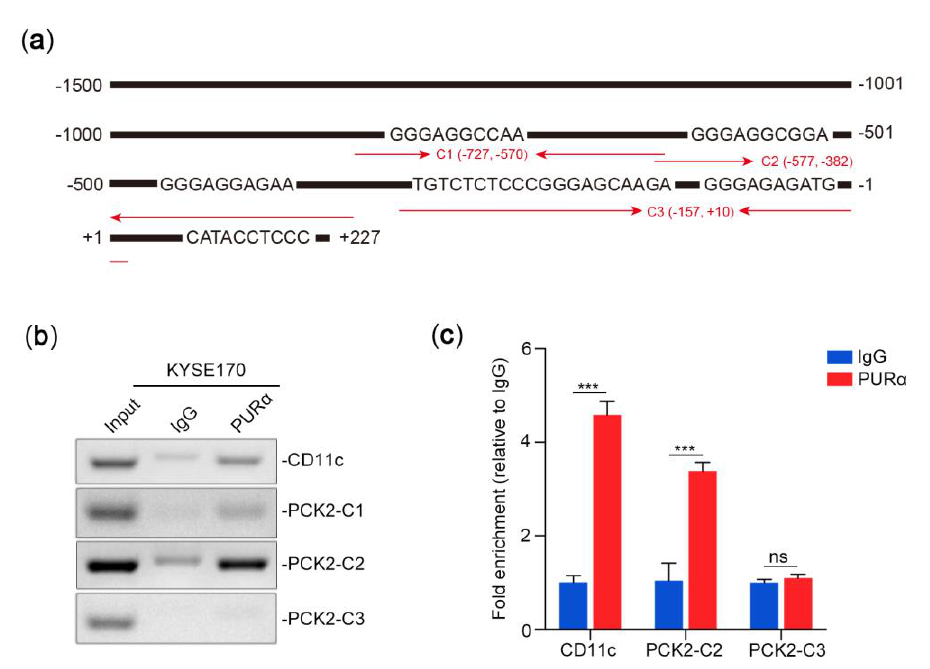
Figure 8. PUR α binds directly to the promoter region of PCK2. ( a ) Schematic diagram showing the specific motifs of 7 PUR α predicted binding sites and the designed C region verified by ChIP-PCR (C1: − 727 / − 570; C2: − 577 / − 382; C3: − 157 /+ 10). ( b ) ChIP-PCR analysis of PUR α binding to the PCK2 promoter region (C1, C2 and C3) and CD11c as a positive control in KYSE170 cells. ( c ) ChIP-qPCR analysis of PUR α binding to the PCK2 promoter C2 / C3 region and CD11c in KYSE170 cells. n = 3. ***, p < 0.001; ns, p > 0.05.